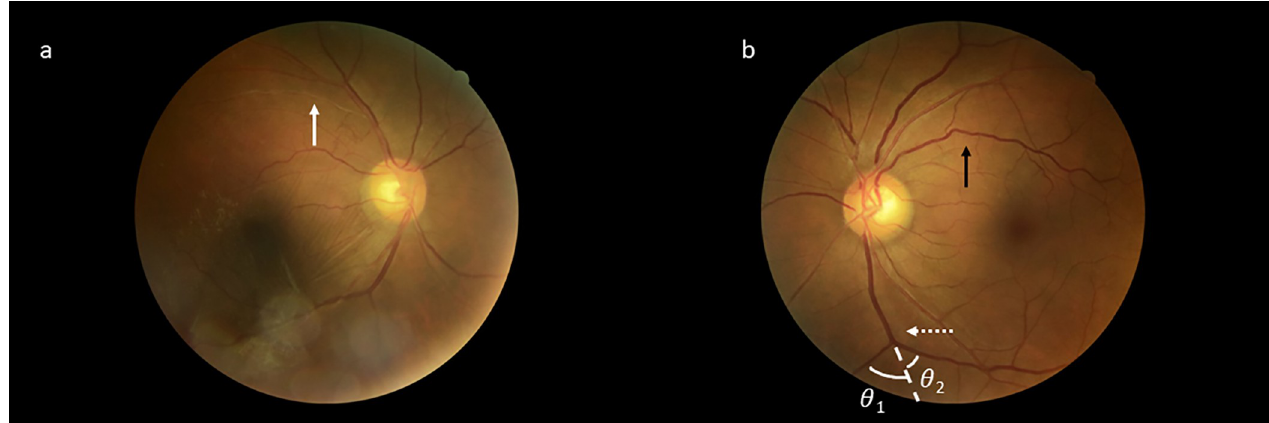
Fig 3. a & b show the retinal images of two participants with coronary artery disease. White arrow indicates arteriole occlusion. Black arrow indicates a venous vessel with significant vascular tortuosity. The dashed white arrow indicates a venous bifurcation; θ 1 and θ 2 specify the bifurcation coefficients of the two branching venules